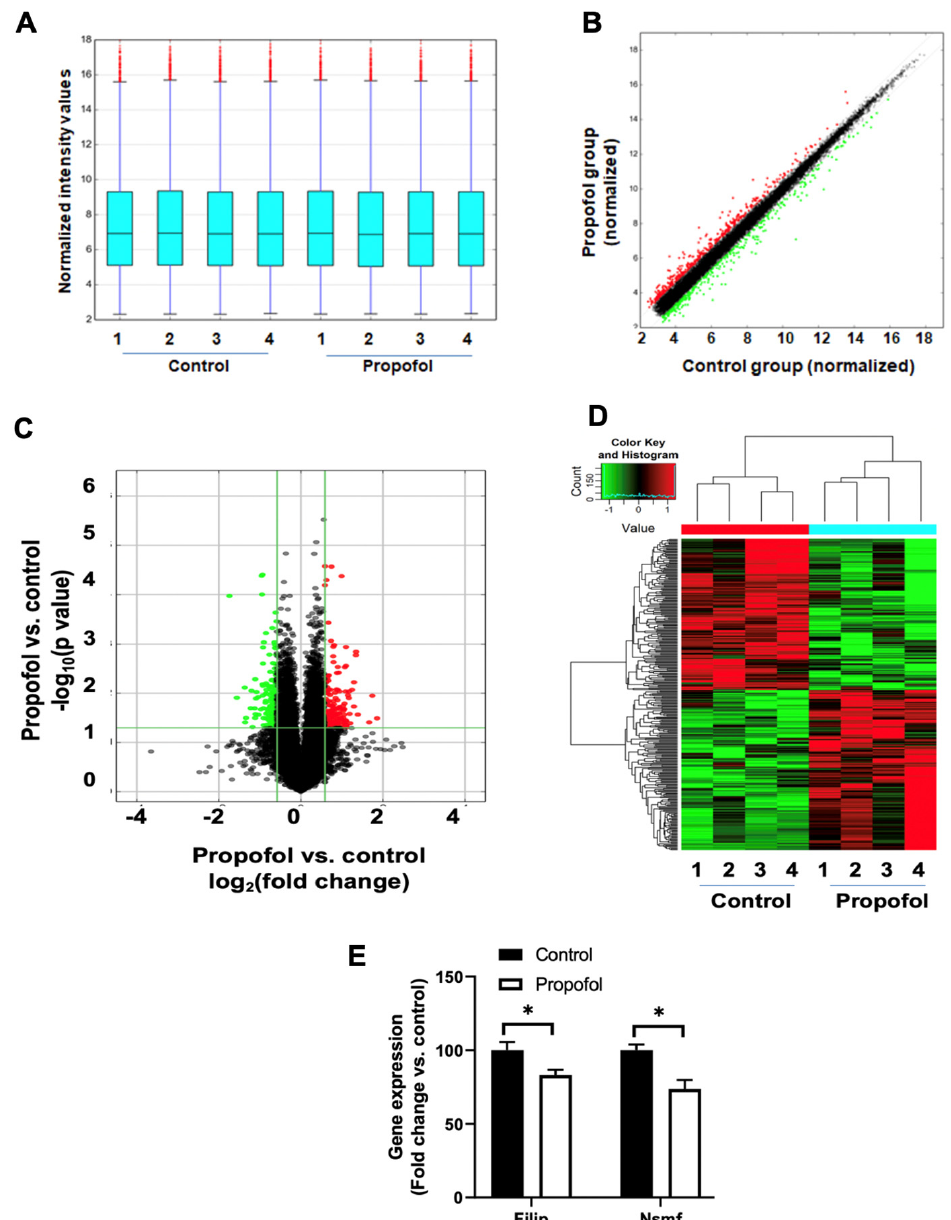
Figure 5. Developmental propofol exposure induced the differential expression of mRNA profiles in the P60 mouse hippocampi. ( A ) The box plots displays the similar distribution of normalized mRNA signal intensity values from 4 control and 4 propofol-treated mouse hippocampal tissues. For each box, the central line represents the median of mRNA intensity values, whereas the tails represent the upper and lower quartiles. ( B ) The scatter plot shows the general consistence of normalized mRNA intensity values from control and propofol groups. ( C ) The volcano plot illustrates the abnormally expressed 317 mRNAs between control and propofol groups. ( B , C ) Red dots: up-regulated mRNAs; green dots: down-regulated RNAs (n = 4, p < 0.05, fold change ≥ 1.5, propofol vs. control). The significant gene names were listed in the Supplementary Table S1. ( D ) Heatmap and hierarchical clustering displays the expression profiles of propofol-induced differentially expressed mRNAs in mouse hippocampi ( p < 0.05). Each row represents the relative expression of each gene. ( E ) RT-PCR validation of the expression of two randomly selected dysregulated mRNAs from microarray assay. n = 4, * p < 0.05.